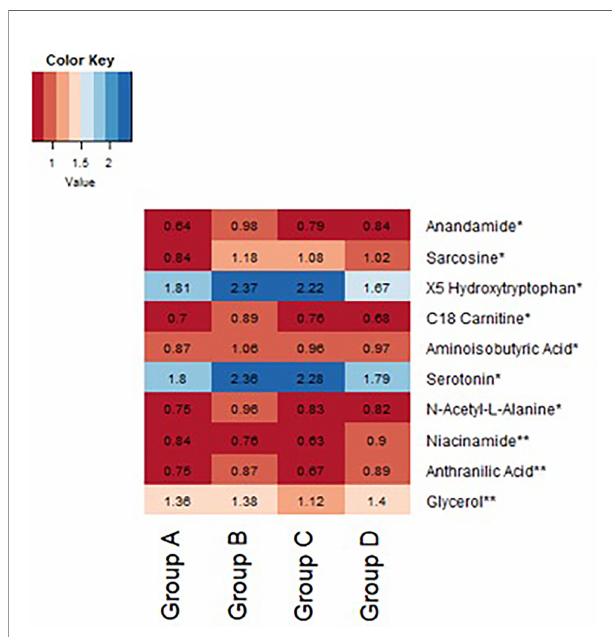
FIGURE 5 | Heatmap demonstrating difference in baseline normalized peak intensities of metabolites between exenatide low responders (Group A, n = 22), exenatide high responders (Group B, n = 14), diet low responders (Group C, n = 11), and diet high responders (Group D, n = 12). *Metabolite peak intensities statistically signi fi cant between Group A and B based on Wilcoxon Rank Sum tests (p<0.05). **Metabolite peak intensities statistically signi fi cant between Group C and D based on Wilcoxon Rank Sum tests (p <